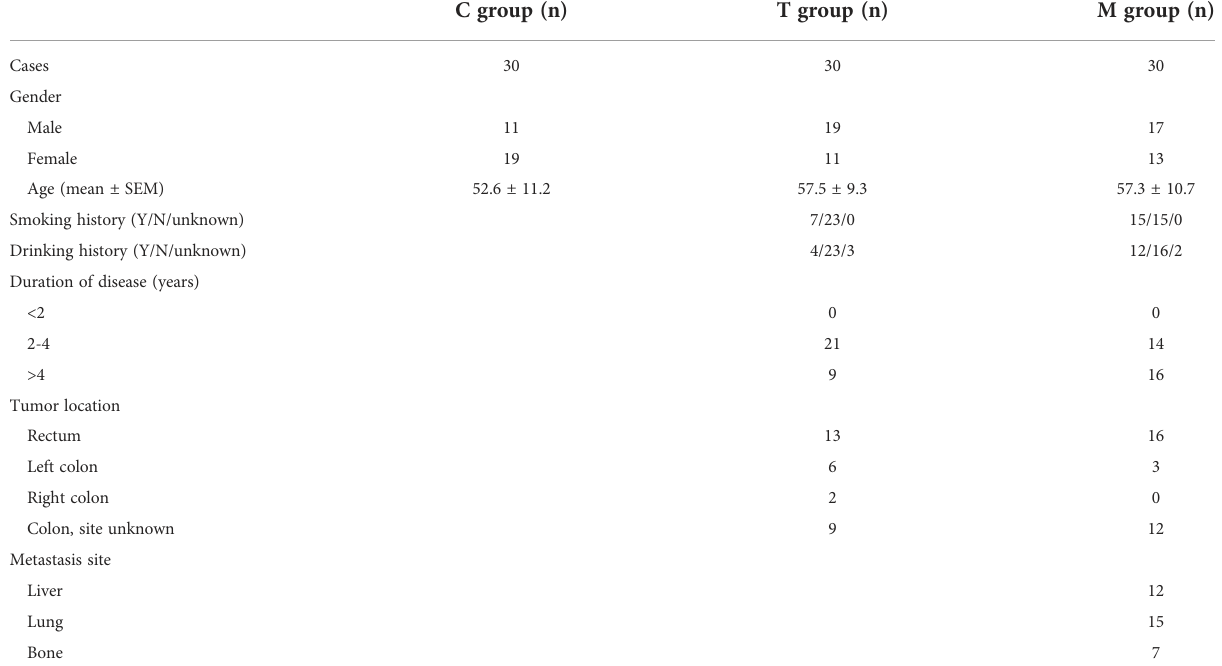
TABLE 1 Characteristics of healthy volunteers and CRC